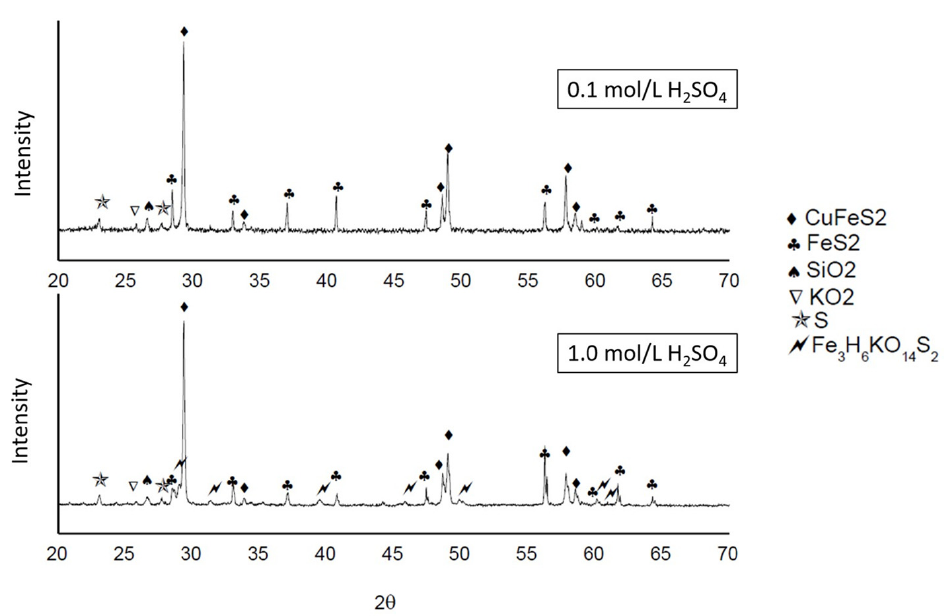
Figure 17. XRD patterns of leaching tests: 0.1 and 1.0 M of H 2 SO 4 and 100 ppm of KI.